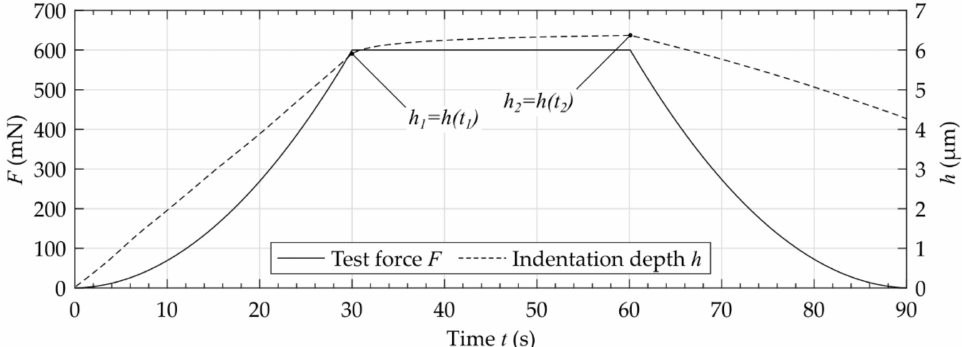
Figure 5. Exemplarily measured curve of test force and indentation